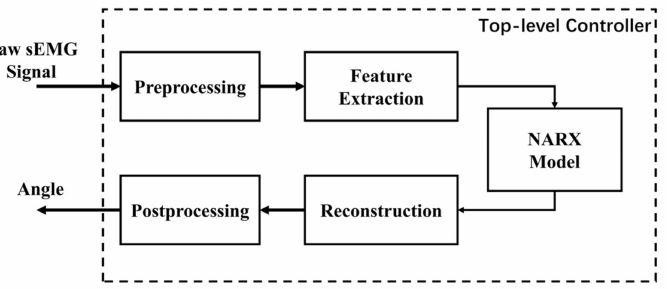
Figure 5. Block diagram of the nonlinear autoregressive exogenous (NARX) model-based top- level controller.